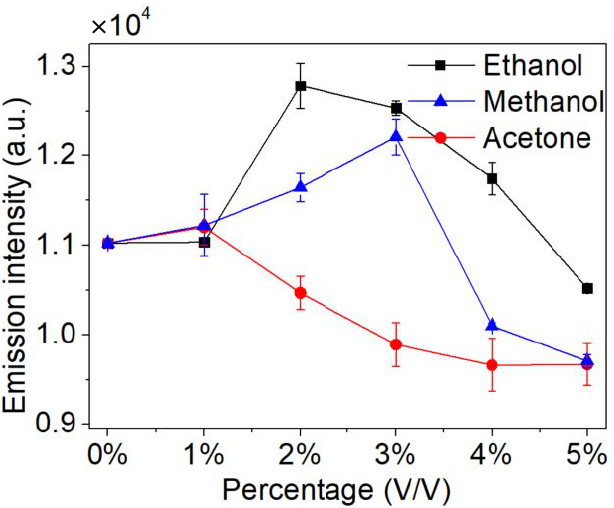
Figure 10. The effects of the low molecular weight organics on emission intensities (applied voltage: 5.6 kV, Ar flow rate: 1.68 L/min, pH = 3.59).